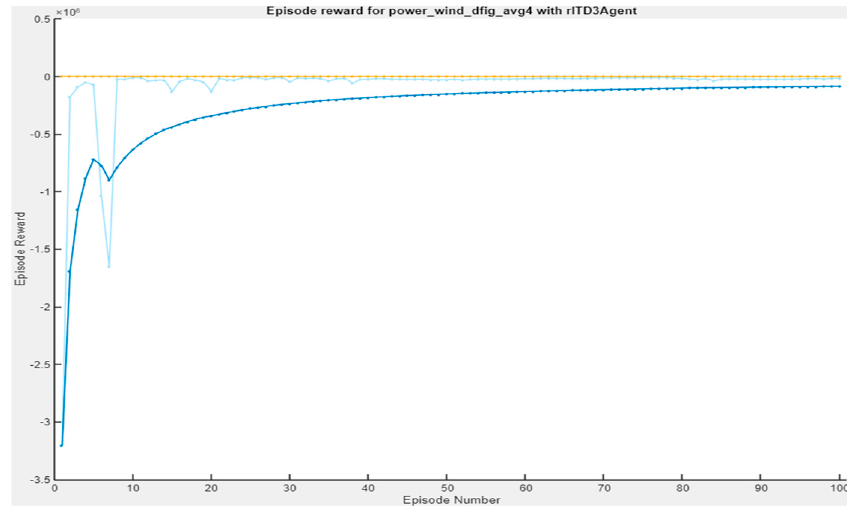
Figure 15. TD3 agent training progress.